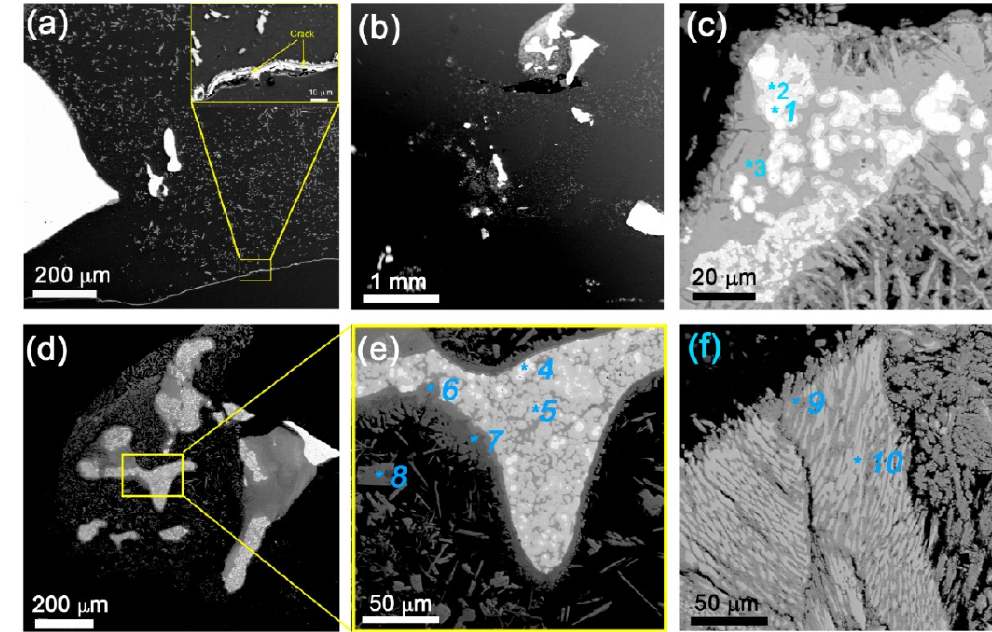
Figure 11. SEM SE ( a , c ) and BSE ( b , d – f ) images of zone 2 AA5154/Mo microstructures obtained with 1.2 g/layer Mo. 1–10 denote points selected for EDS (Table 6). Table 6. EDS analysis of the AA5154/Mo with 1.2 g/layer was obtained by using SEM (Figure 11e,f). Concentration of Elements, at.% Spectrum